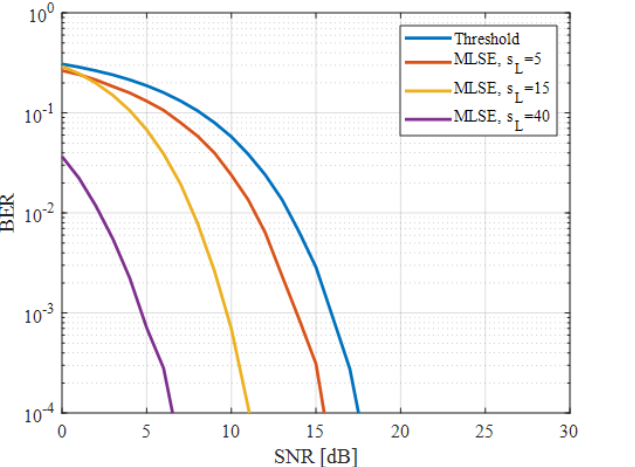
Figure 11. BER characteristics of demodulation method by the proposed MLSE